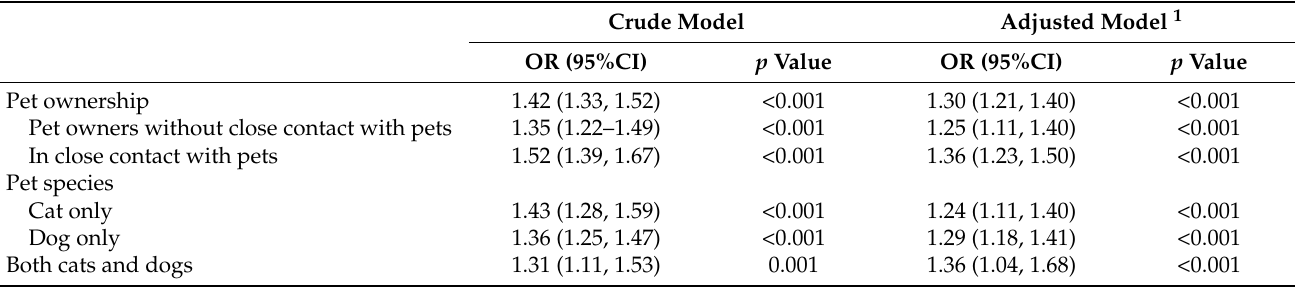
Table 2. Odds ratios (ORs) and 95% confidence intervals (CIs) of associations between pet exposure and threatened